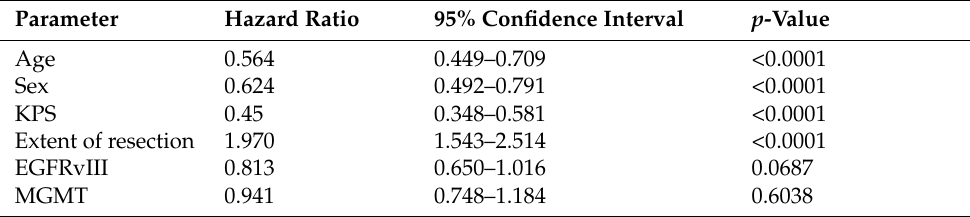
Table 4. Cox multivariate analysis for survival.